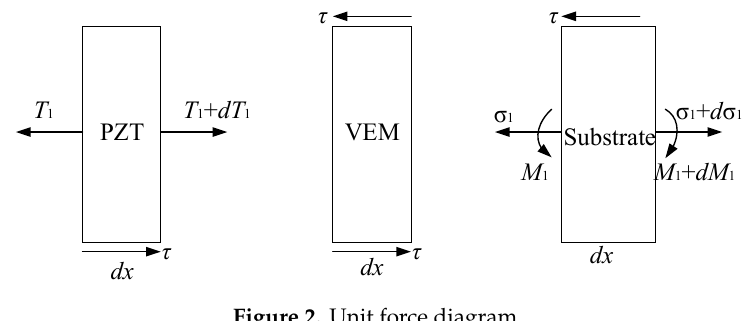
Figure 1. Shear force transfer graph.